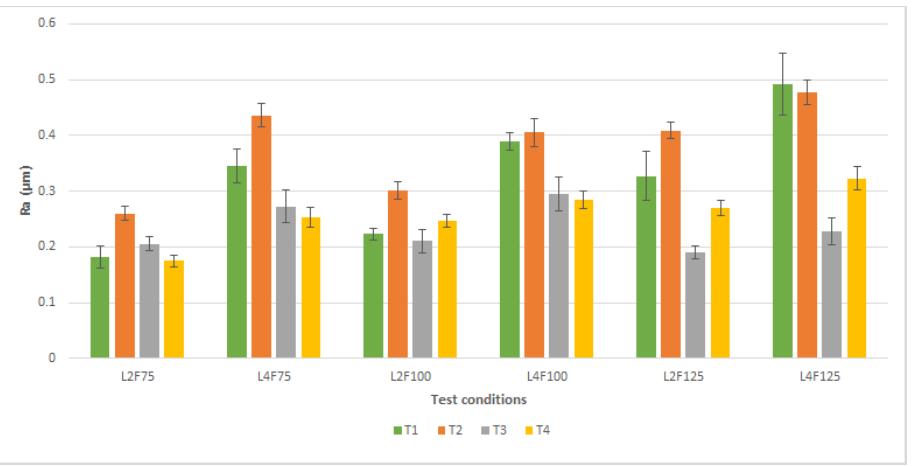
Figure 20. Average values of Ra, measured in the tangential direction, produced by T1, T2, T3 and T4 tools for all the different test conditions.